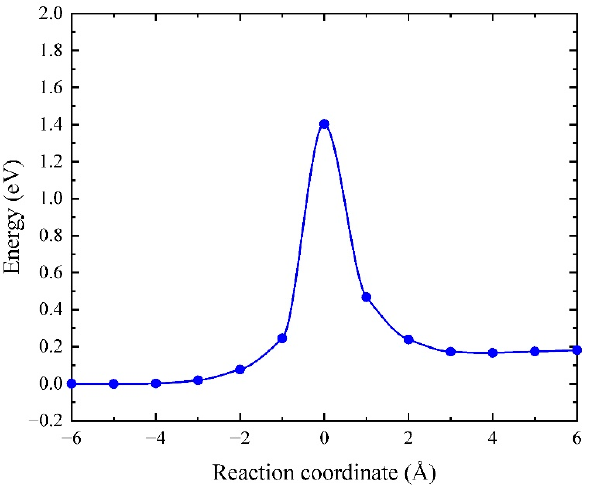
Figure 3. (Color online) The calculated minimum energy path (MEP). Blue circles correspond to NEB images. Reaction coordinate describes the process of an incident H atom approaching the hydrocarbon chain along the x -direction and fleeing away by detaching a hydrogen atom from the hydrocarbon chain and forming a H 2 molecule. Zero coordinate is set as the position of the H atom residing at the s1 position mentioned in Table 1.